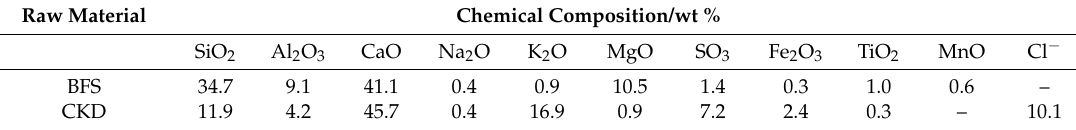
Table 1. Chemical composition of BFS and CKD as determined by